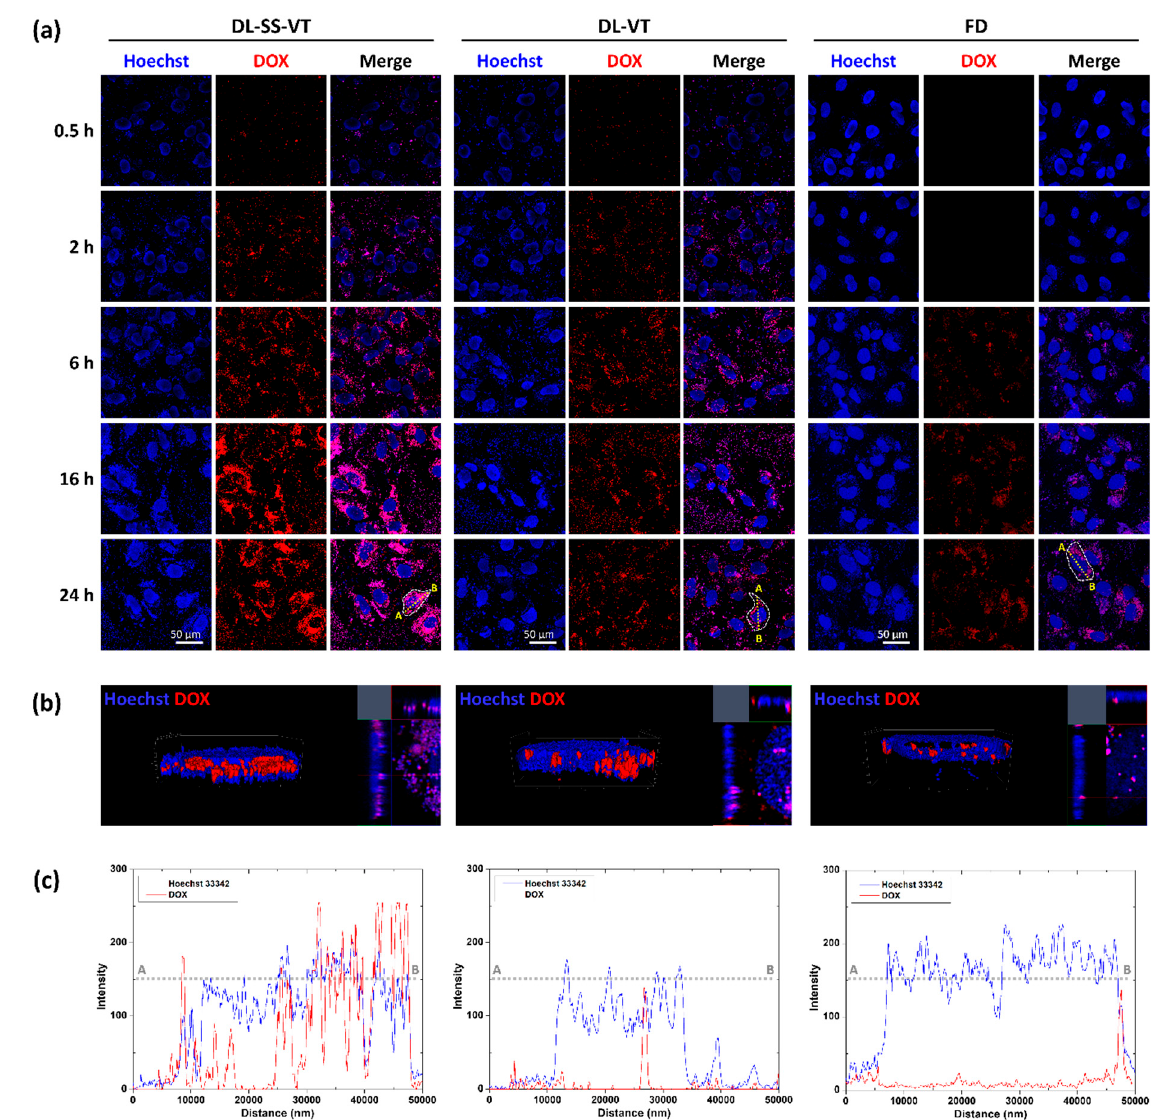
Figure 7. ( a ) CLSM images of Huh-7 cells incubated with DL-SS-MC, DL-MC, or FD for 0.5, 2, 6, 16, or 24 h. Blue and red fluorescence represent cell nuclei (Hoechst 33342) and DOX, respectively. Scale bar = 50 μ m. ( b ) 3D reconstructions and Z-stack images (left and right side of each set, respectively) of Huh-7 cells incubated with DL-SS-MC, DL-MC, or FD for 24 h. ( c ) Localization of DOX in the cell nuclei is confirmed by intensity overlay of the fluorescence signals.